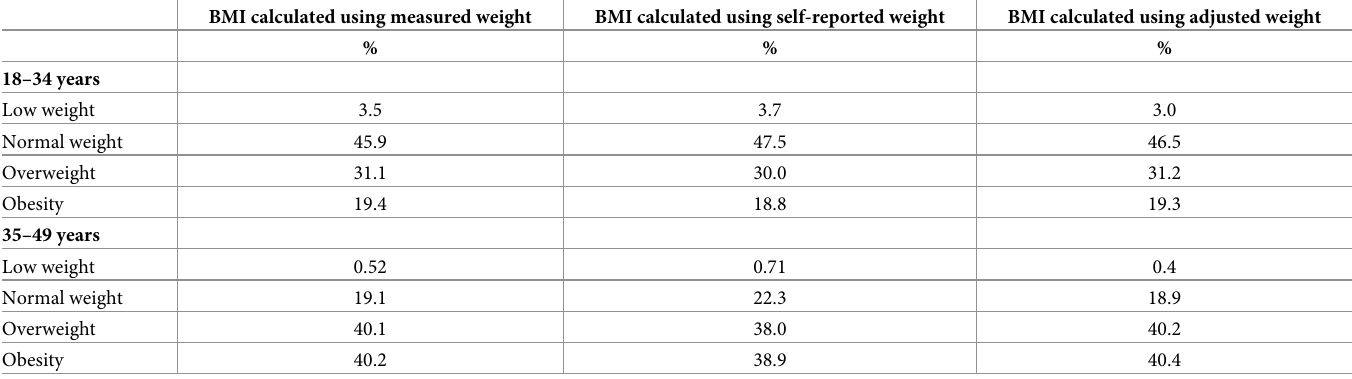
Table 4. Distribution of BMI based on different versions of weight by age